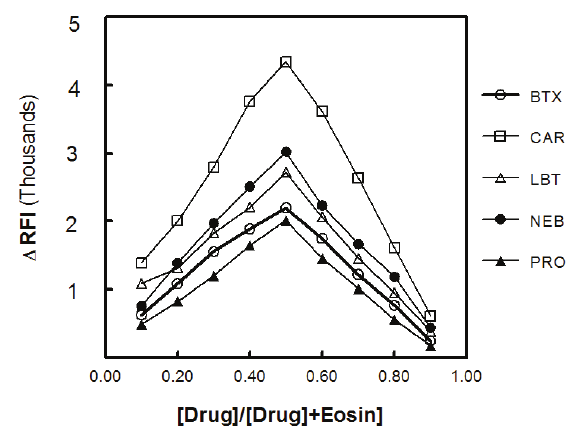
Figure 3: Job’s plots for molar ratio determination using equimolar solutions (3.47 x10 -5 M) of both eosin Y and the investigated drugs at pH